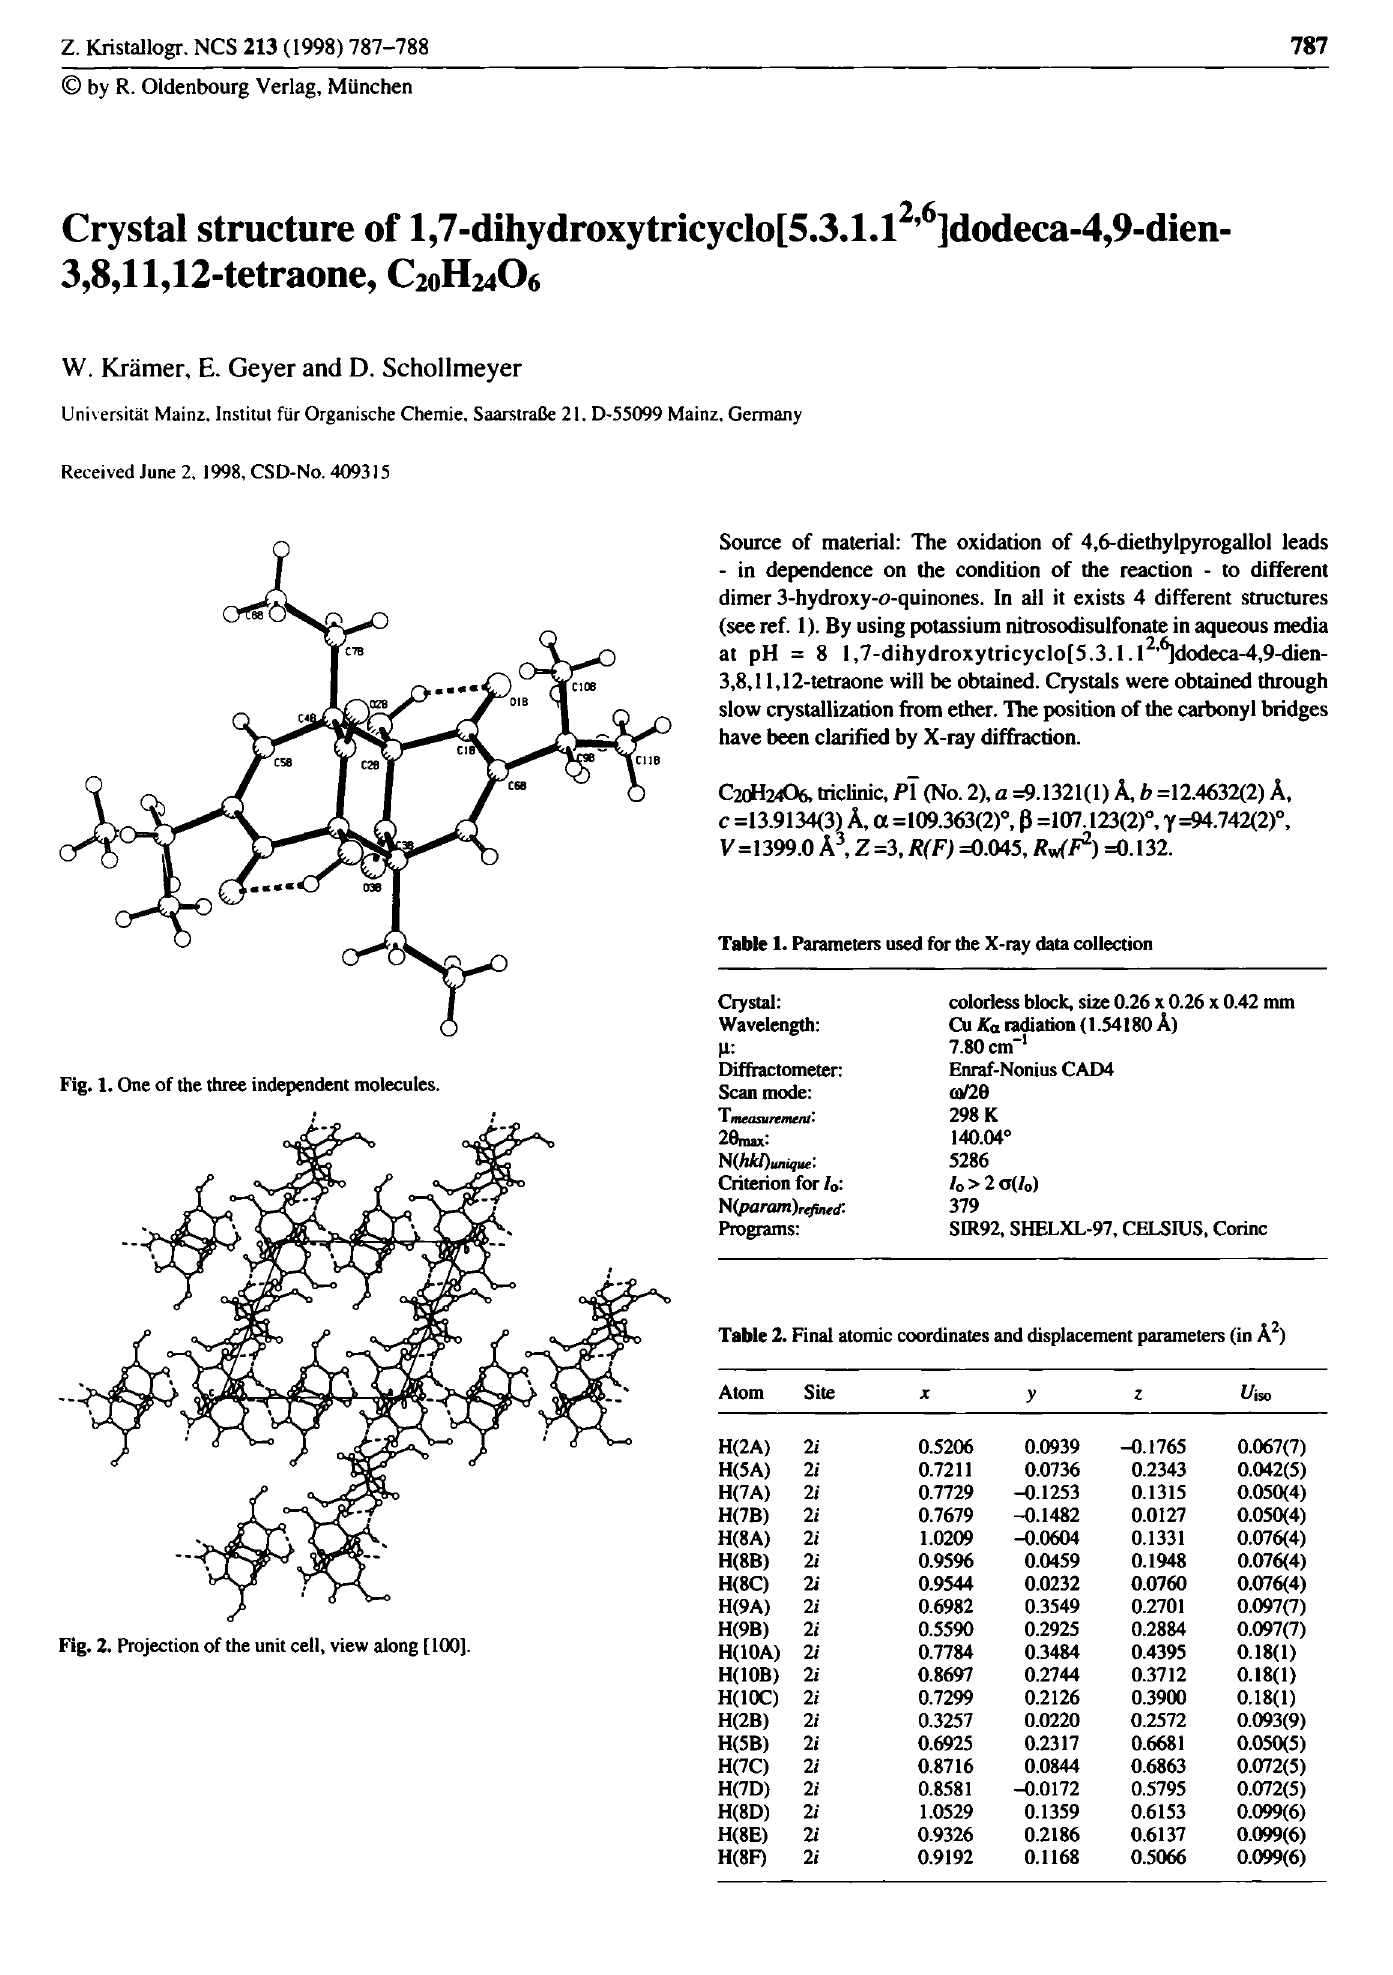
Table 2. Final atomic coordinates and displacement parameters (in